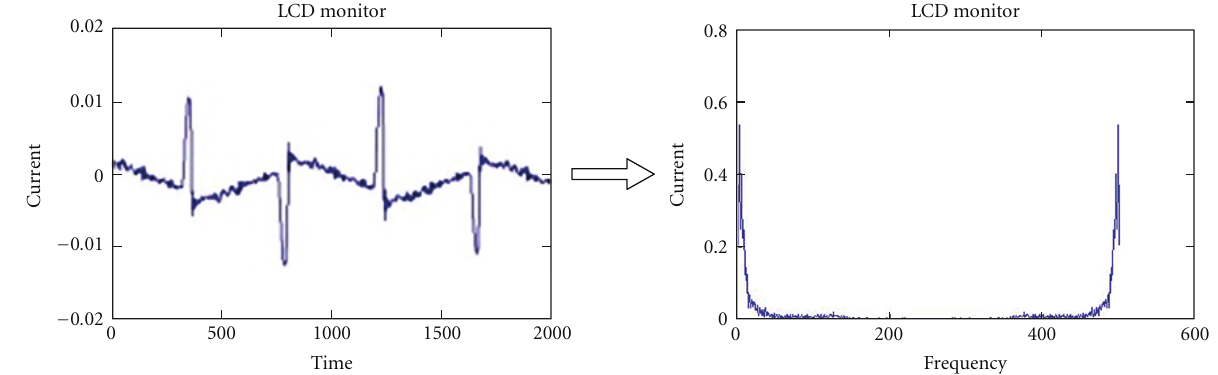
Figure 2: Load current signal of LCD monitor in time and frequency domains.